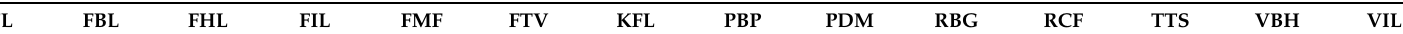
Table 14. Semi-Covariance